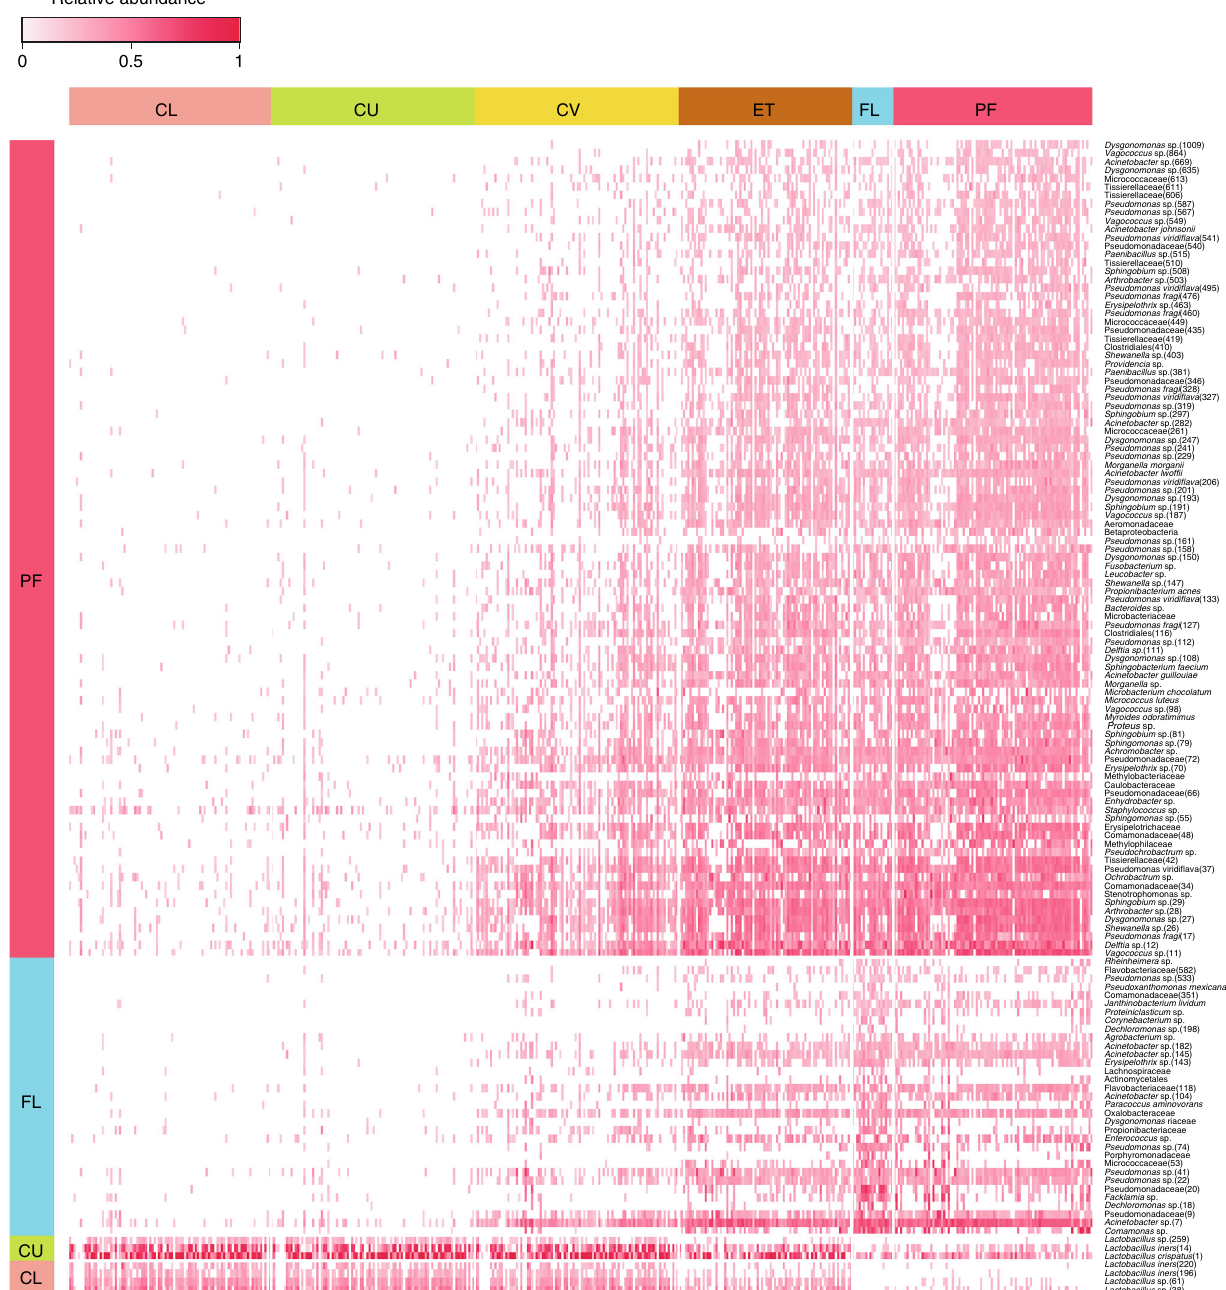
Fig. 2 Signature species for each body site. Heatmap for the relative abundances of signature OTUs from each body site ( P < 0.05, multi-level pattern analysis, and IndVal > 0.5). Each bar represents one sample ( n = 94 CL, 95 CU, 95 CV, 80 ET, 93 PF, 9 FLL and 10 FRL, Supplementary Data